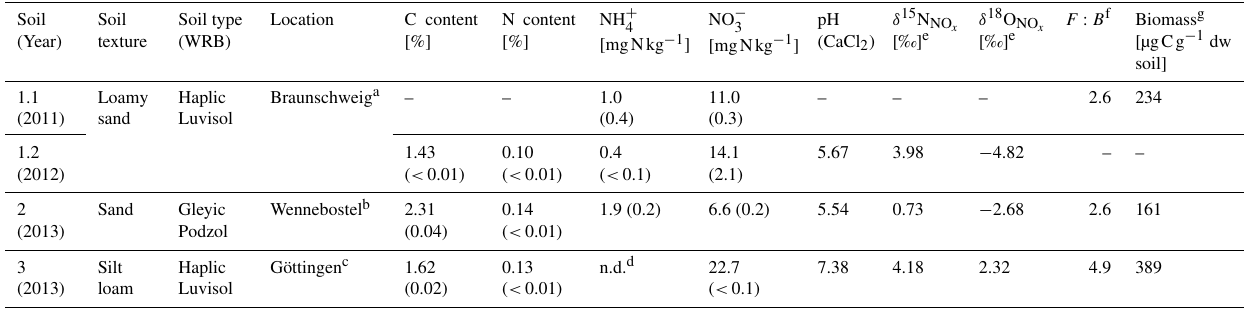
Table 1. Soil characteristics of three arable soils from Germany used for incubation experiments (Soil) (standard deviation in brackets). Except for NH + and NO − , soil characteristics (C, N, pH, δ 15 N NO 4 3 collected in 2012. WRB: World Reference Base for Soil